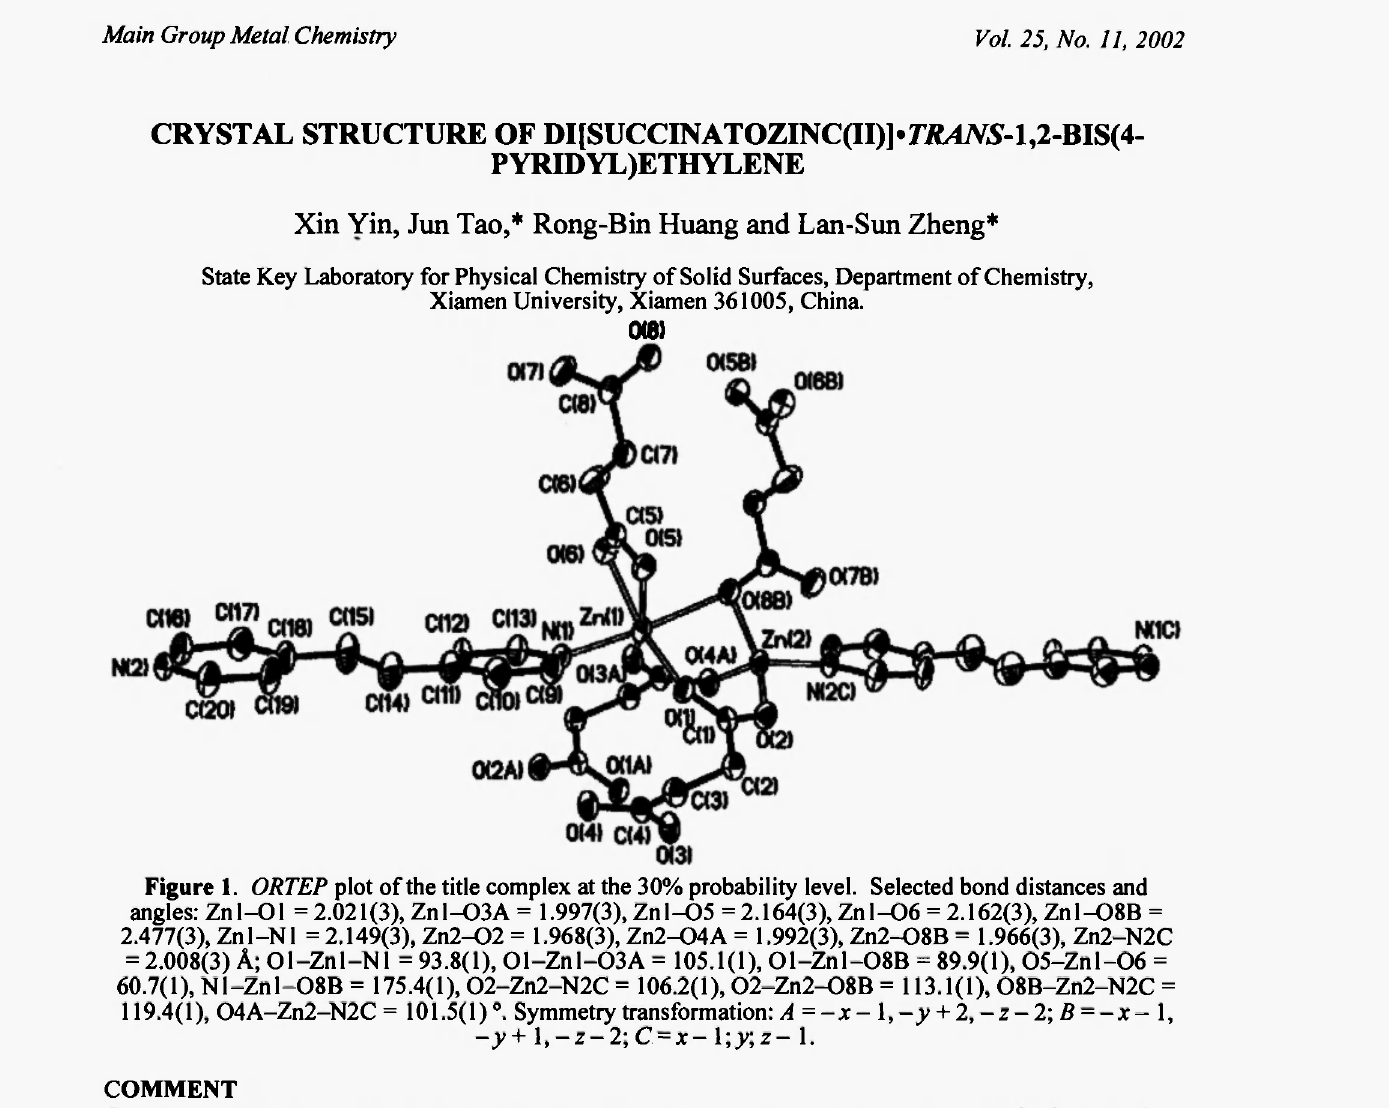
Figure 1. ORTEP plot of the title complex at the 30% probability level. Selected bond distances and angles: Znl-Ol = 2.021(3), Znl-03A = 1.997(3), Znl-05 = 2.164(3), Znl-06 = 2.162(3), Znl-08B = 2.477(3), Znl-Nl = 2.149(3), Zn2-02 = 1.968(3), Zn2-04A = 1.992(3), Ζη2-Ό8Β = 1.966(3), Zn2-N2C = 2.008(3) A; Ol-Znl-Nl = 93.8(1), 01-Znl-03A = 105.1(1), 01-Znl-08B = 89.9(1), 05-Znl-06 = 60.7(1), Nl-Znl-08B = 175.4(1), 02-Zn2-N2C = 106.2(1), 02-Zn2-08B = 113.1(1), 08B-Zn2-N2C = 119.4(1), 04A-Zn2-N2C = 101.5(1)°. Symmetry transformation:/! = - x-